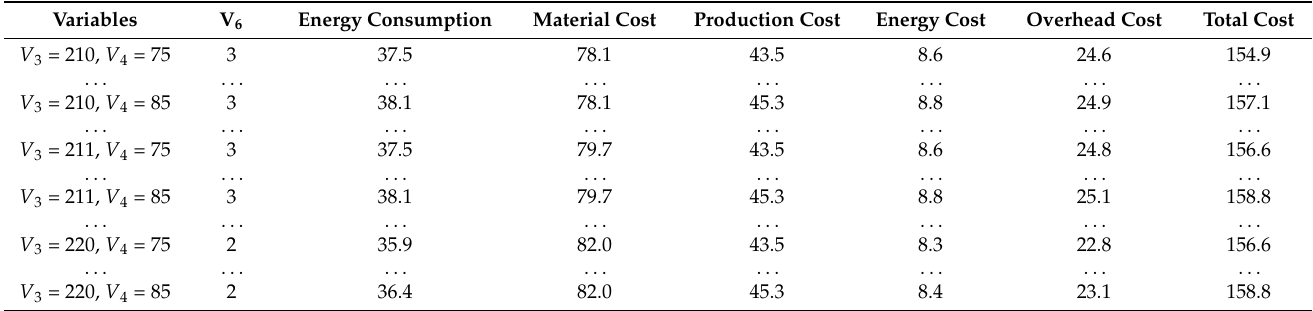
Table 5. Simulations of changes in energy consumption and related